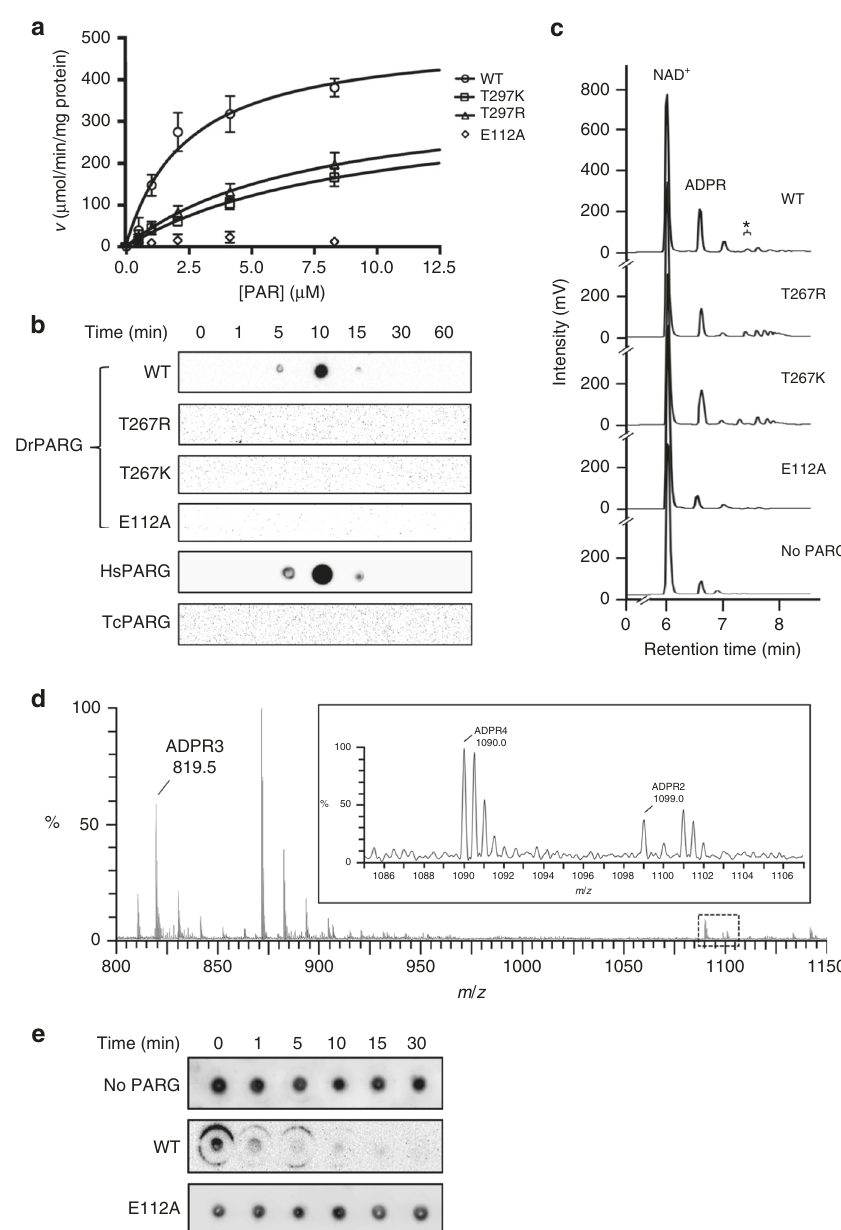
Fig. 5 Enzyme activity of DrPARG. a Michaelis – Menten plots of wild-type (WT), T267R, T267K, and E112A DrPARG catalyzing poly-ADP-ribose (PAR) hydrolysis are shown. Initial reaction velocity ( μ mol/min/mg protein) is plotted against PAR substrate concentration ( μ M). Data are plotted as mean ± SEM ( n = 3 independent experiments). WT, T267R, T267K, and E112A DrPARG are indicated by open circle, triangle, square, and diamond, respectively. b Detection of PAR in the cleavage products of DrPARG. The reaction of automodi fi ed PARP1 treated with or without (time = 0) WT and mutant DrPARG was stopped at different times and fi ltered with a 30-kDa cut-off column. PAR was assayed in the fi ltrate by dot blotting. PARGs from Homo sapiens (HsPARG) and Thermomonospora curvata (TcPARG) were used as controls of canonical and bacterial PARG, respectively. c The products of reactions treated with WT and mutant DrPARG for 15 min were fi ltered with a 10-kDa cut-off column and subjected to high-performance liquid chromatography (HPLC) analyses. ADP-ribose (ADPR) and residual NAD + were indicated. The fraction indicated by an asterisk from cleavage products of WT DrPARG was collected and analyzed by mass spectrometry. d Identi fi cation of endo-glycohydrolase cleavage products of DrPARG by time-of- fl ight mass spectrometry (TOF MS). The cleavage products separated by HPLC were subjected to a quadrupole time-of- fl ight (Q-TOF) instrument for analysis. Ion chromatogram was shown with m / z ratios for deprotonated ADPR dimer (ADPR2; m / z 1099.0), doubly charged deprotonated ADPR trimer (ADPR3; m / z 819.5), and doubly charged deprotonated ADPR tetramer (ADPR4; m / z 1090.0) indicated. e Enzyme activity of DrPARG toward endogenous PAR of D. radiodurans was assayed in cell lysates from the Δ parg strain treated with or without (time = 0) WT or E122A DrPARG. PAR level was assayed by dot blotting over a